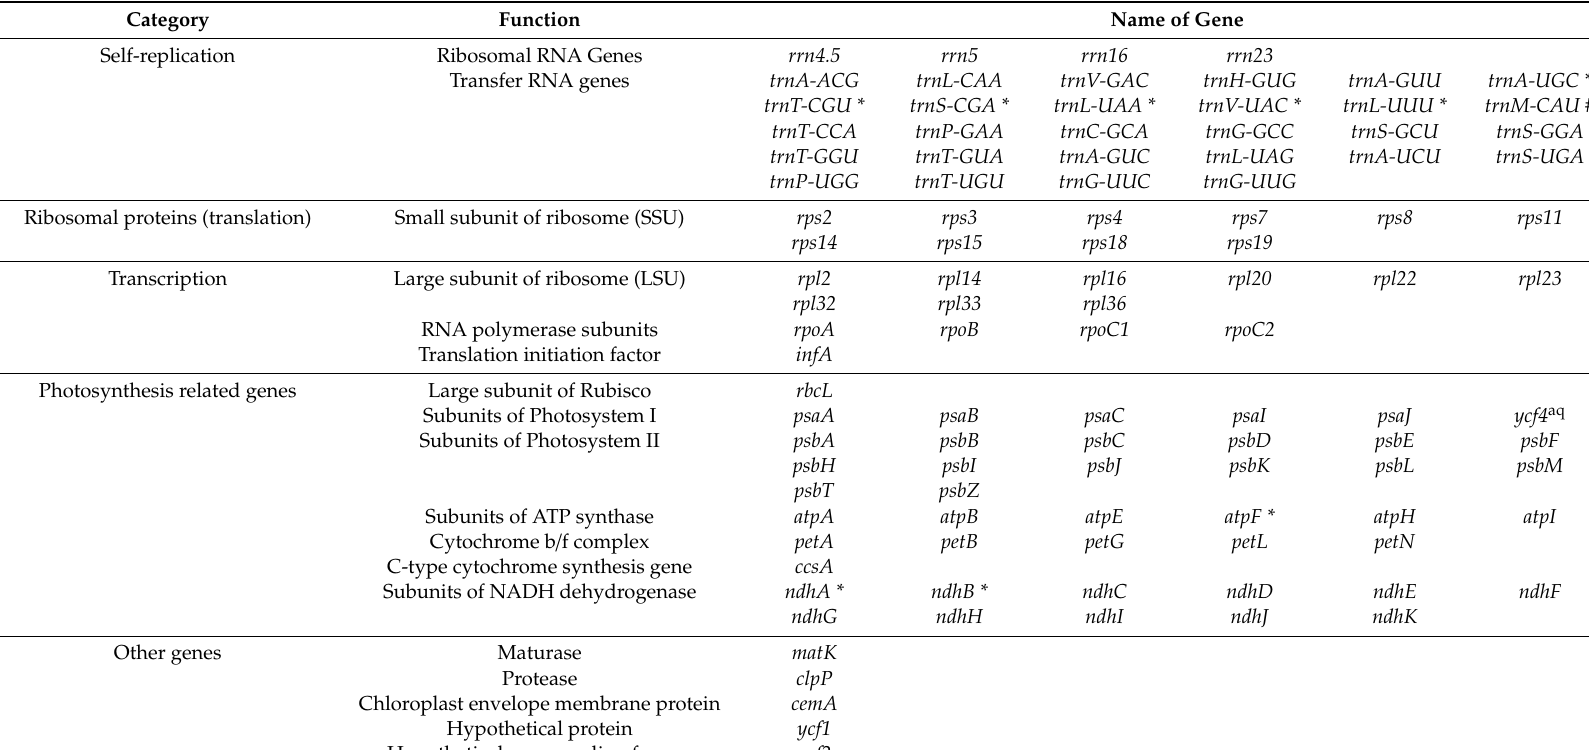
Table 2. List of cp genes annotated in the three Phalaris cp genomes sequenced in this